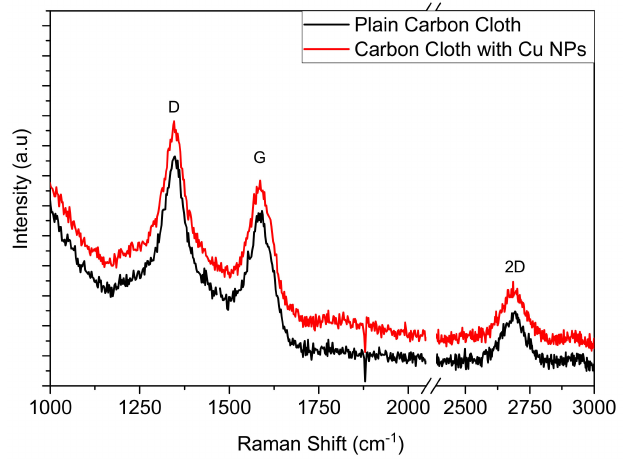
Figure 2. Raman spectrum of plain CC fabric and decorated with Cu NPs, exhibiting the characteristic peaks D, G and 2D of carbon